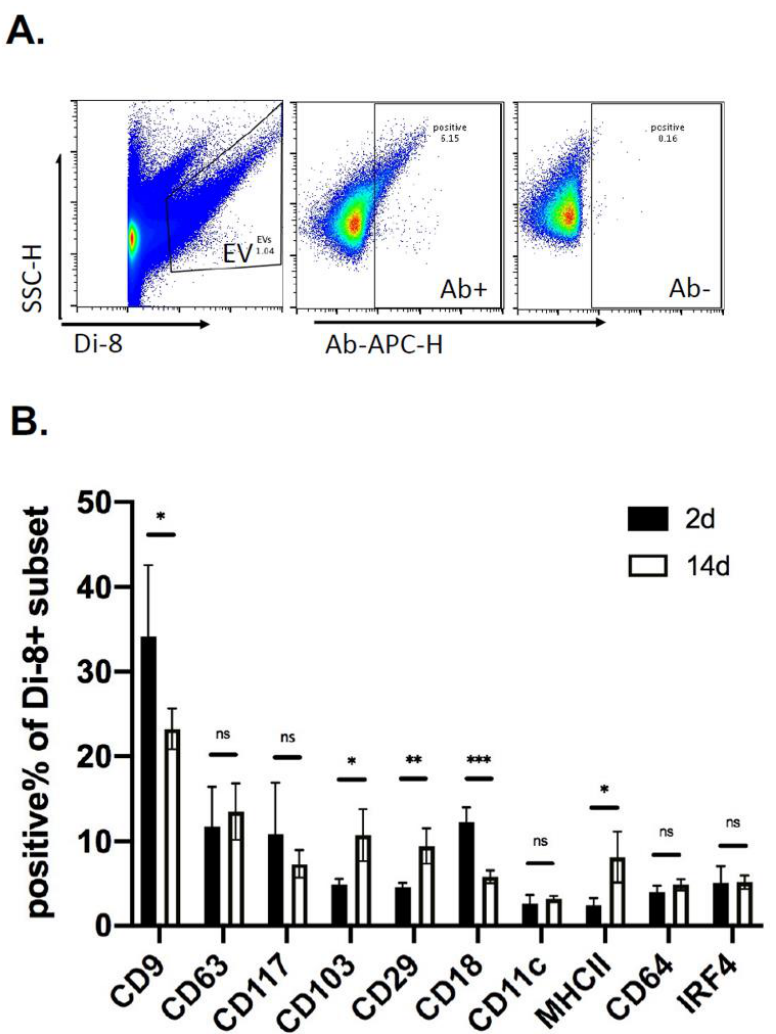
Figure 6. Kinetics of EV proteins in PVA sponges measured using vFC. ( A ) EVs isolated from C57 BL/6 mice were normalized by protein concentration, stained with di-8 fluorescent dye, labeled with allophycocyanin (APC)-labeled antibodies, and analyzed by modified flow cytometry as described in the Materials and Methods. ( B ) Expression of immune cell-related proteins on the surface EVs analyzed 2 and 14 days post-implantation. Data shown are mean ± SD. ( n = 5; * p < 0.05, ** p < 0.01, and *** p < 0.001). Table 1. Antibodies used for analysis of EV surface markers using vesicle flow cytometry.